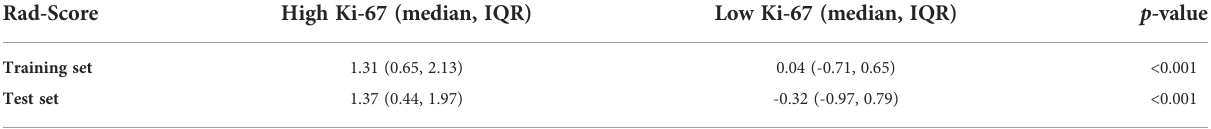
TABLE 4 Rad-Score for the training and test